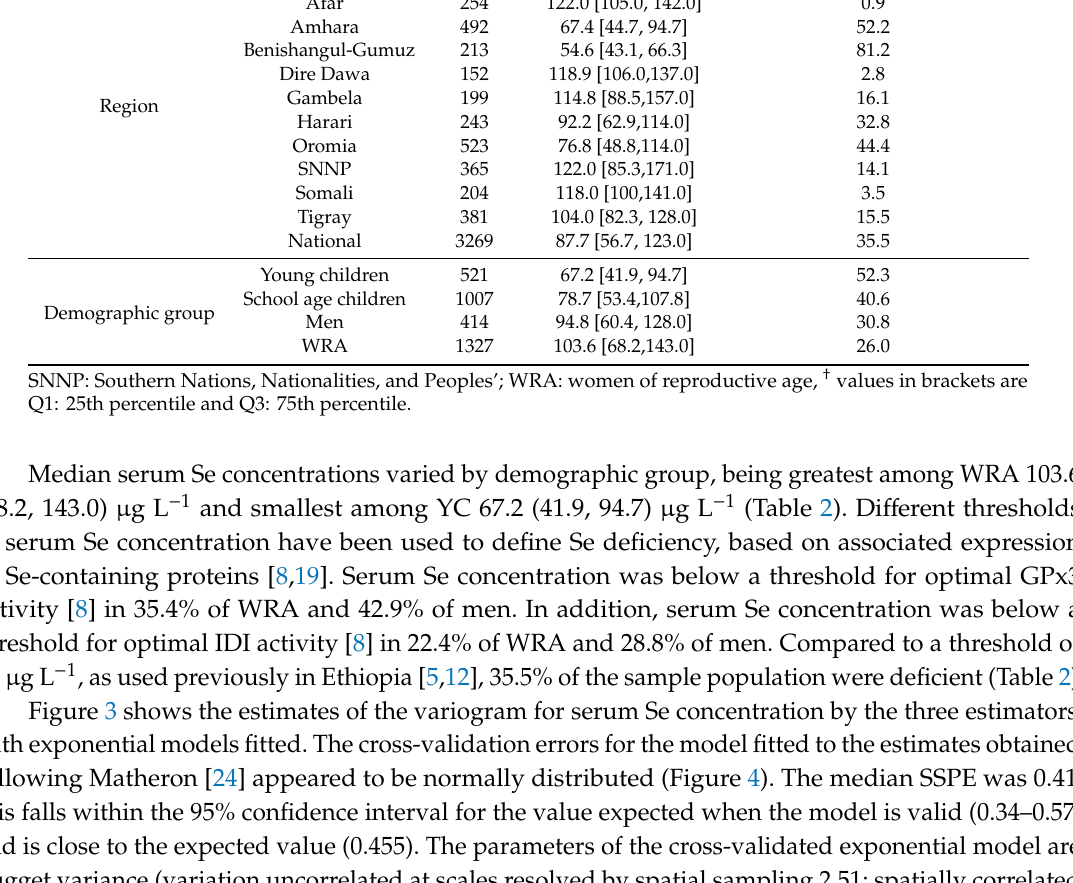
Figure 4. Histogram of the cross-validation errors using the variogram fitted to estimates obtained with the Matheron estimator [24]. The Box-plot shows the median and quartiles (box limits). The vertical dashed line shows the outer fence values of Tukey [20].